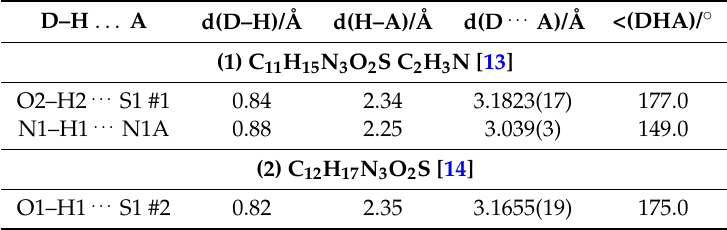
Table 6. Hydrogen bond interactions for ( 5 ) and ( 6 ) [Å and ˝